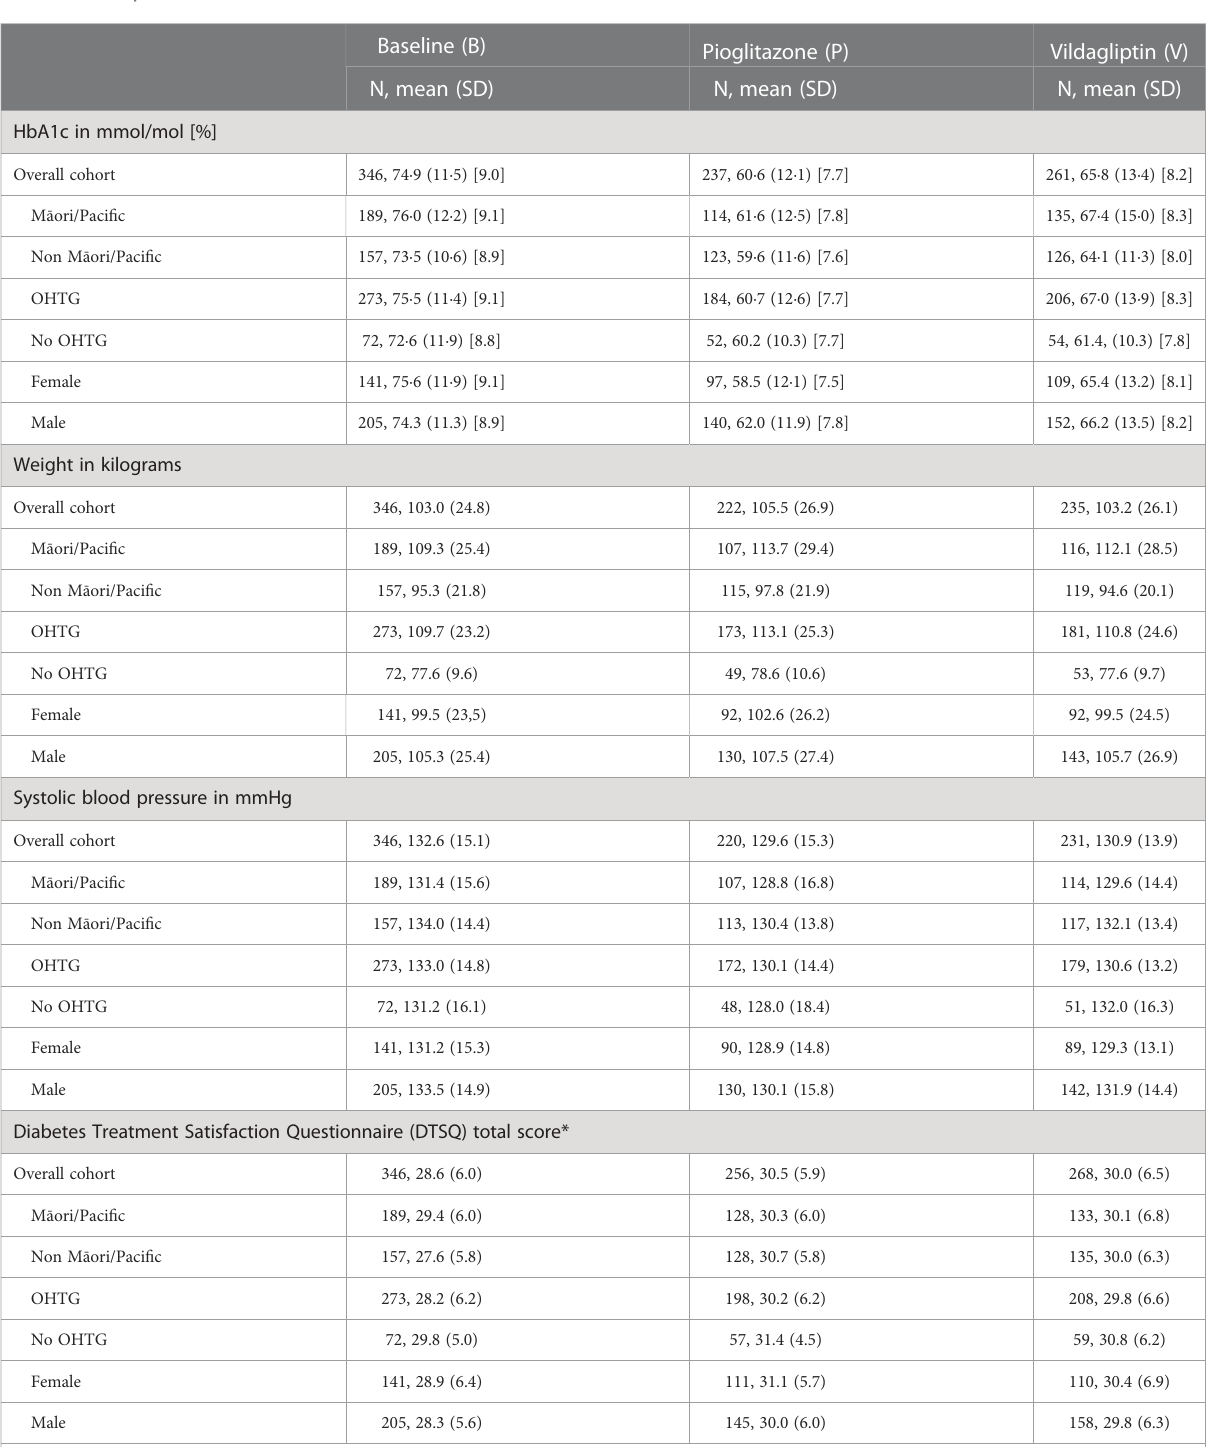
TABLE 2 Descriptive data at baseline and after each